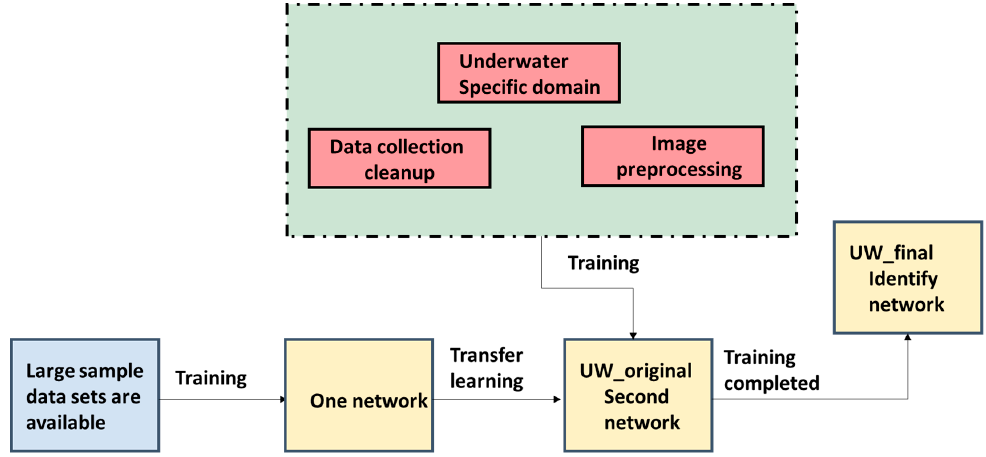
Figure 7. Underwater target detection network structure. The Faster R-CNN network used in this paper adopted the VGG16 classification network as its backbone.